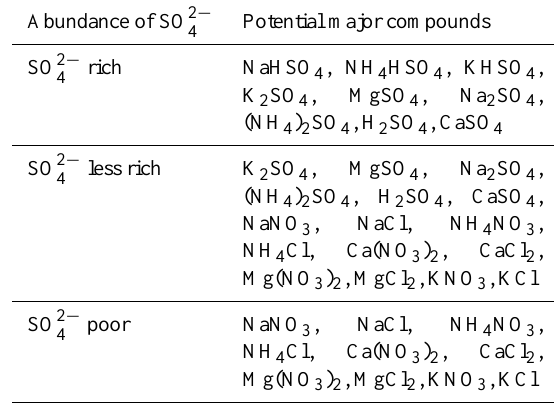
Table 2. Potential major compounds with respect to the abundance of SO 2 − 4